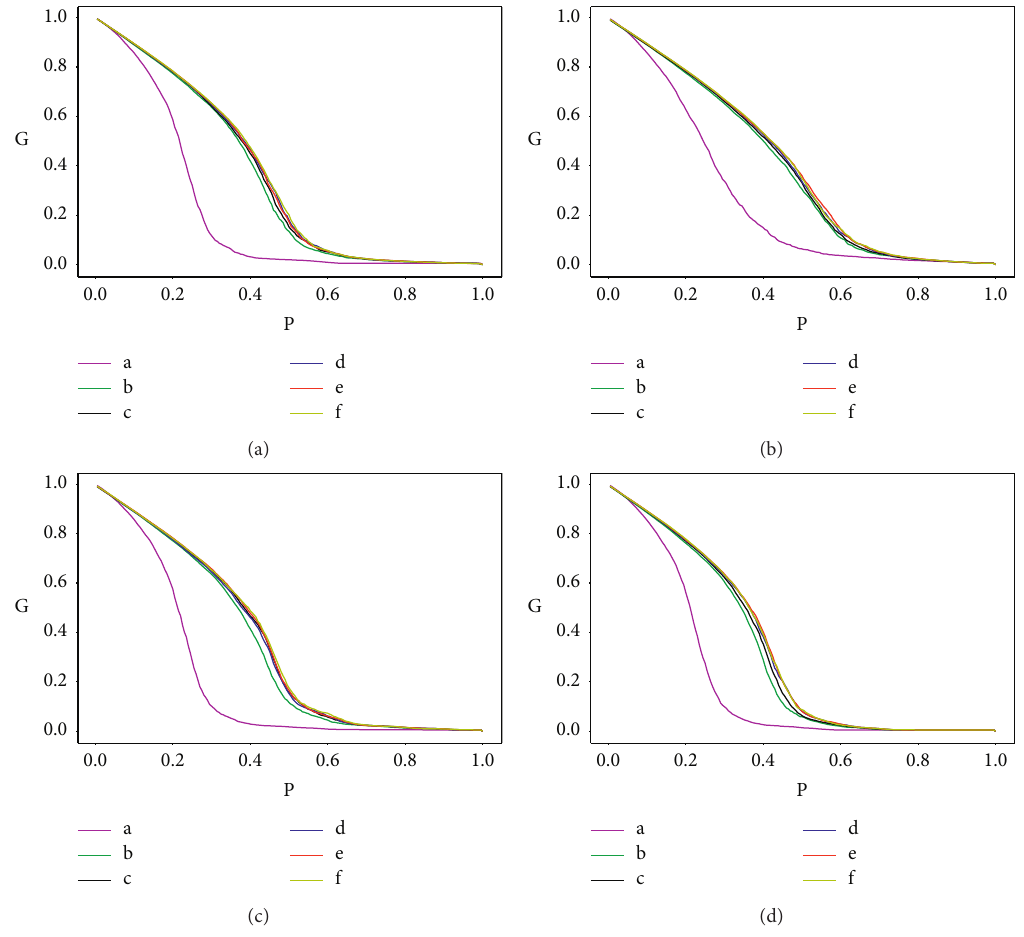
Figure 5: The change of the maximum connectivity coefficient G after model B is attacked by different algorithms, where N � 200, M � 3, curve a represents the BA network, and curve b-f represents the comparison of different parameters of model B (where threshold � 0.1–0.5, changes � 0.001). (a) deg, (b) SL, (c) LLS, and (d)